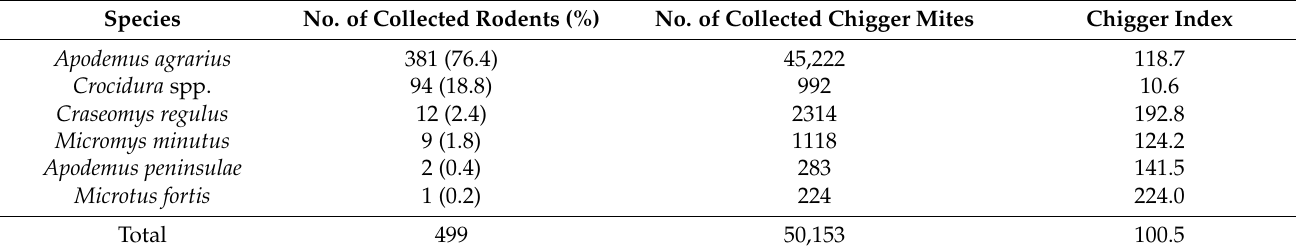
Table 2. Number of collected wild rodents and chigger mites from wild rodents in the Republic of Korea in 2020. Species